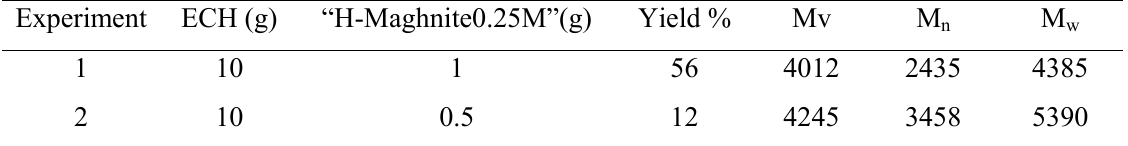
Table 3. Polymerization of Epichlorhydrin induced by the “H-Maghnite0.25M” Experiment